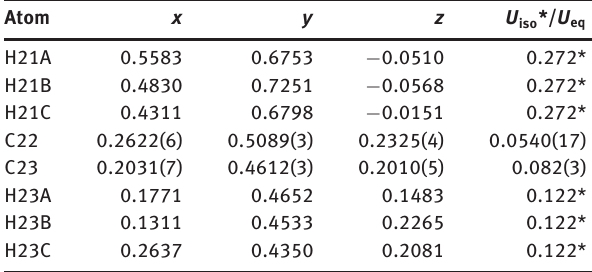
Table 2: Fractional atomic coordinates and isotropic or equivalent isotropic displacement parameters (Å 2